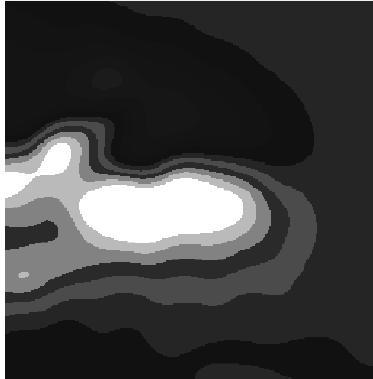
figure.4 Aero-magnetic residual contour